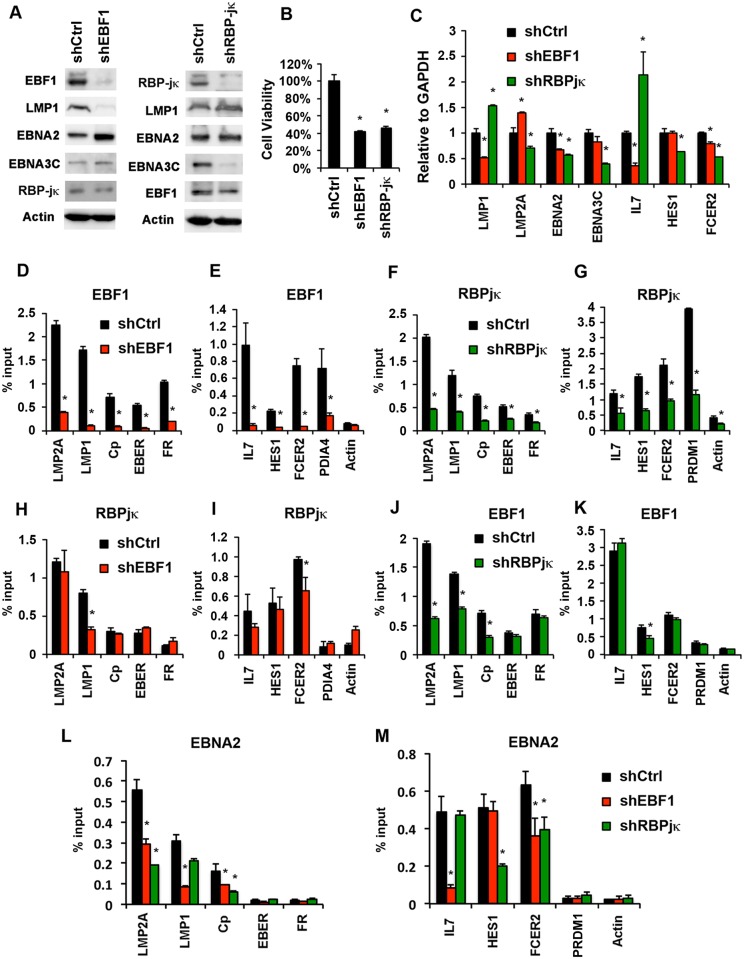
EBF1 and RBP-jκ function at EBNA2 co-occupied sites.
(A) Western blots of LCL cells transduced with either control shRNA (shCtrl) or shEBF1 (left) or shCtrl or shRBP-jκ (right) lentivirus and probed for EBF1, RBP-jκ LMP1, EBNA2, EBNA3C, or Actin. (B) Cell viability determined by Resazurin assay for LCL cells 7 days after shRNA lentivirus transduction. (C) RT-qPCR (ΔΔCT) analysis of EBV or cellular gene transcription (as indicated) in LCLs transduced with either shEBF1 (red), shRBP-jκ (green), or shCtrl lentivirus (black). (D-M) ChIP-qPCR in LCLs with antibodies to either EBF1 (panels D, E, J, K), RBP-jκ (panels F, G, H, I), or EBNA2 (panels L and M). LCLs were transduced with either shCtrl (black), shEBF1 (red), or shRBP-jκ (green). Viral (panels D, F, H, J, L), or cellular (E, G, I, K, M) sites were analyzed as indicated. Asterisk indicates p < 0.05.